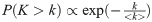
Evolution of the degree distribution of the world cereals trade network.A. Degree distribution in 1986. The cumulative density function follows a power law of type P(K > k) ∝ k−α) with kmin = 15 and α = 2.02. The Kolmogorov-Smirnov statistic is: Dn = 0.0857. The power law property is a characteristic of a scale free network, the degree of a few nodes greatly exceeds the average degree of nodes. The highest-degree nodes are the “hubs”, and serve specific purposes in the networks, here they are major exporting countries. B. Degree distribution in 2013. The cumulative density function fits with an exponential function of type P(K>k)∝exp(-k<k>) where < k > = 82.85 is the average degree of nodes. C. Kolmogorov-Smirnov distance. The distance, Dn, is represented over time for the fit with a power law distribution (blue line) and with an exponential distribution (black line). The Kolmogorov-Smirnov statistic, Dn, gives the distance between the data and the fit. Minimizing this value equates to optimizing the fit. Until 1996, the Dn value was lower for the power law fit than for the exponential fit; the inverse is true after 1997. Thus, the fit of the power law becomes less accurate and the fit of the exponential distribution becomes more accurate. These two trends confirm the evolution of the degree distribution from scale free to exponential.